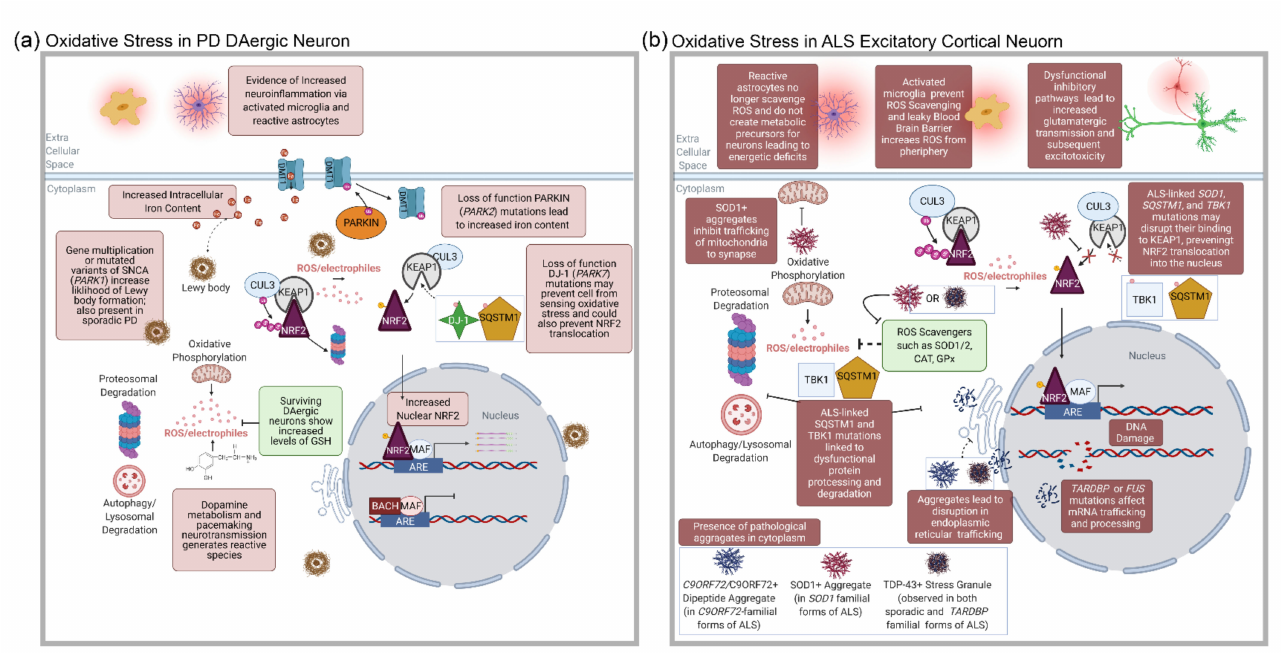
Figure 4. Schematics show how the cellular REDOX factors discussed in this review could be affected by, or contribute to, disease-specific stressors in the context of midbrain DAergic neurons in PD ( a ) and excitatory cortical neurons in ALS ( b ). Considerations include observations from clinical data, post-mortem tissue studies, and putative mechanisms derived from model systems. Created with BioRender.com (accessed on 25 October